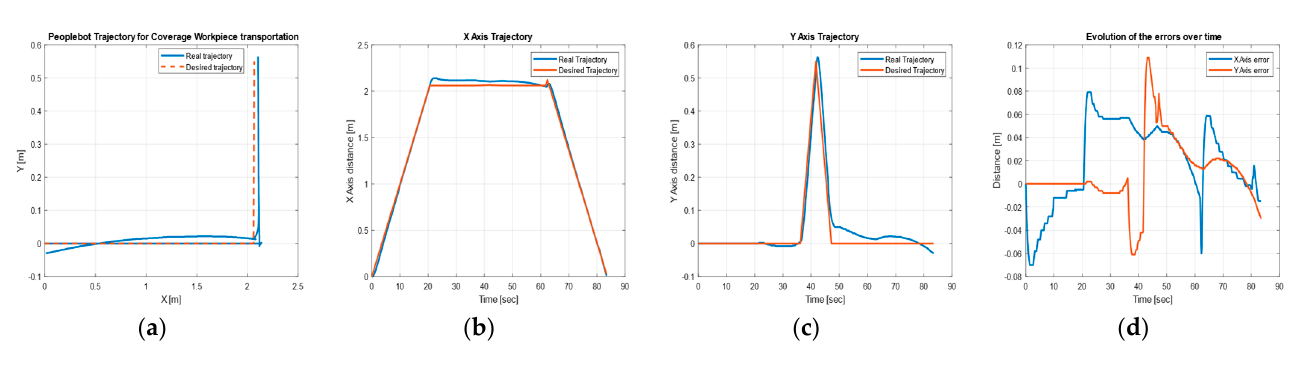
( d ) Figure 26. CAS’s DT-TTSMC for body recovery: ( a ) desired and real trajectory; ( b ) along the X axis; ( c ) along Y axis; ( d ) errors. In the “Digital Twin” approach from this paper, for both the virtual and the real world, the following software products and packages were used for simulation, monitoring, and control: Sirphyco [32], Microsoft visual studio C++ [48]; Advanced Robotic Interface for Applications (ARIA) [49]; MobileSim [33], Siemens Totally Integration Automation (TIA-Portal V.15) [34]; Open CV [45]; MATLAB [46].